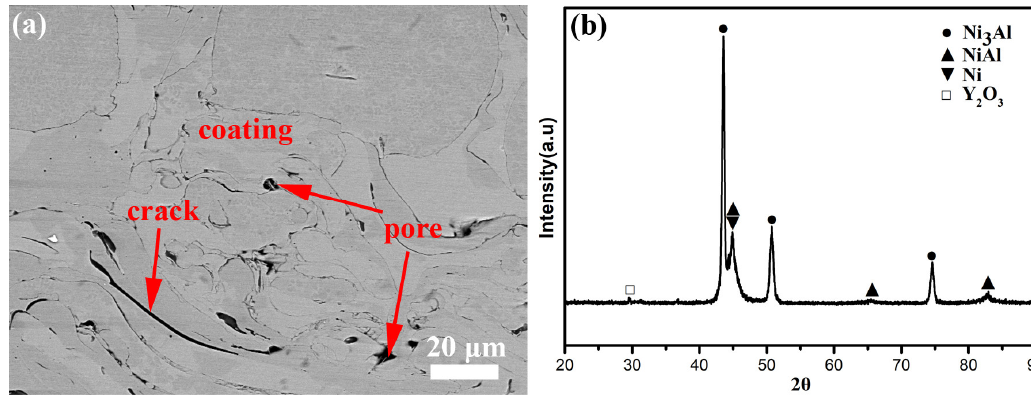
Figure 3. SEM morphology of ( a ) cross-section and ( b ) XRD pattern of NiCrAlY coating.